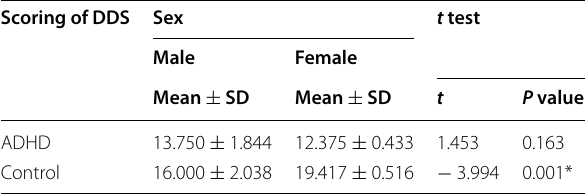
DDS Dysgraphia Disability Scale